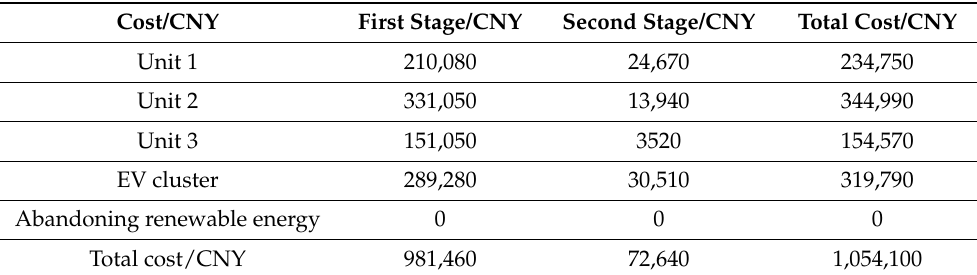
Figure 7. The results of the second stage optimization. Table 1. The total optimized cost for 96 time periods.